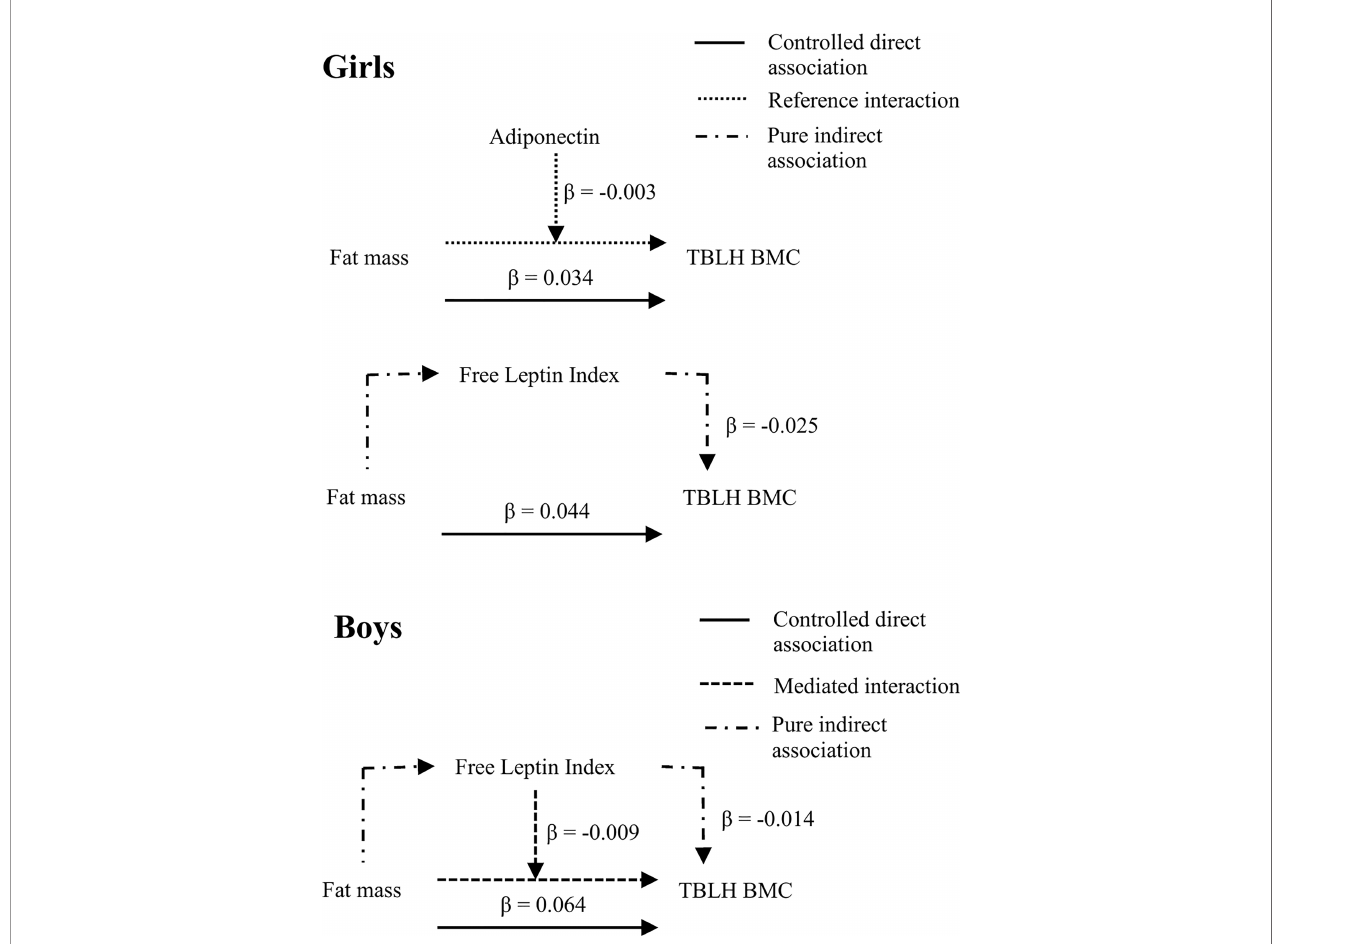
FIGURE 3 | Summary of signi fi cant mediation and moderation effects from the 4-way decomposition. Total body less head bone mineral content, TBLH BMC. All models adjusted for age, stature, pubertal status, lean mass, and baseline TBLH BMC. Girls: n = 191 for adiponectin, n = 190 for free leptin index, Boys: n =